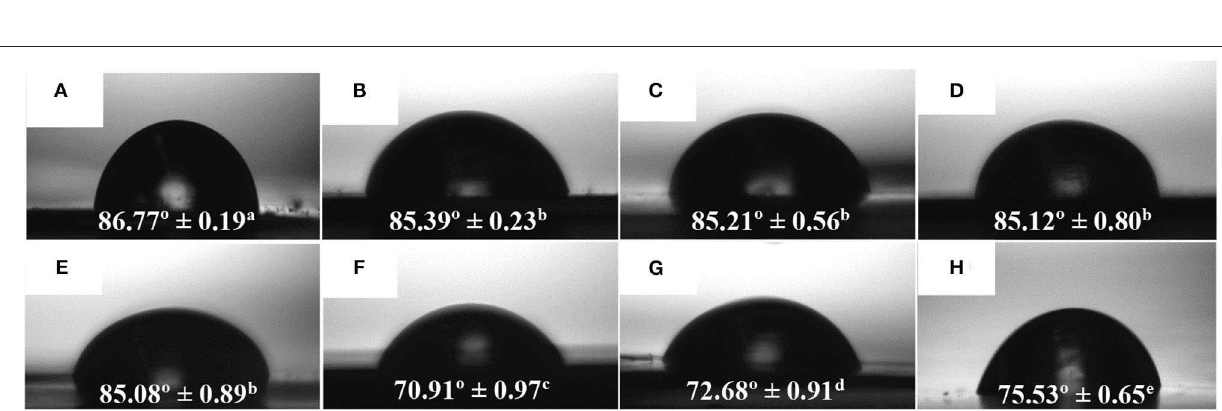
FIGURE 6 | Scanning electron microscopy (SEM) micrographs of the multilayer structure of poly(3-hydroxybutyrate) (PHB) sheet/electrospun poly(3-hydroxybutyrate- co -3-hydroxyvalerate) (PHBV) interlayer containing eugenol/PHBV film: (A) bottom view of the structural layer of PHB: (B) top view of the food contact layer of PHBV; (C) multilayer cross-section.